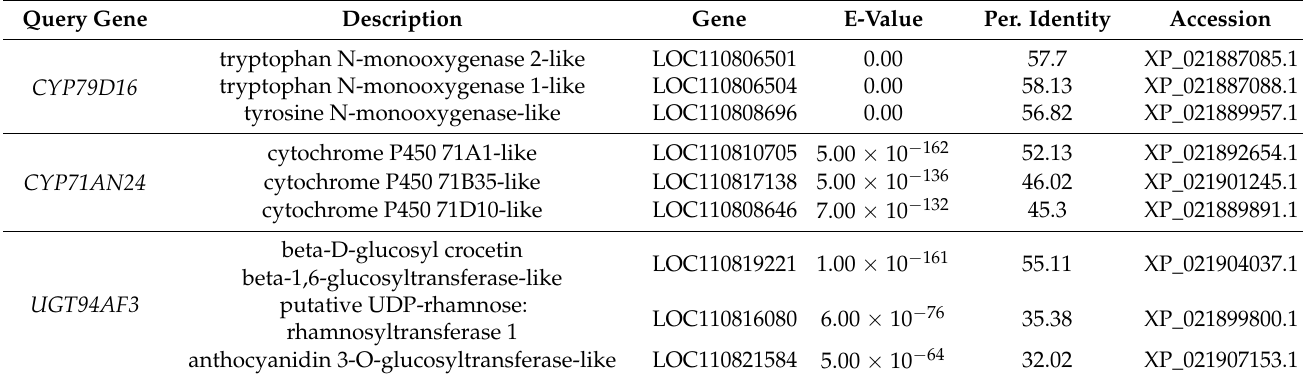
Table 3. Novel biosynthetic CG genes identified in papaya using